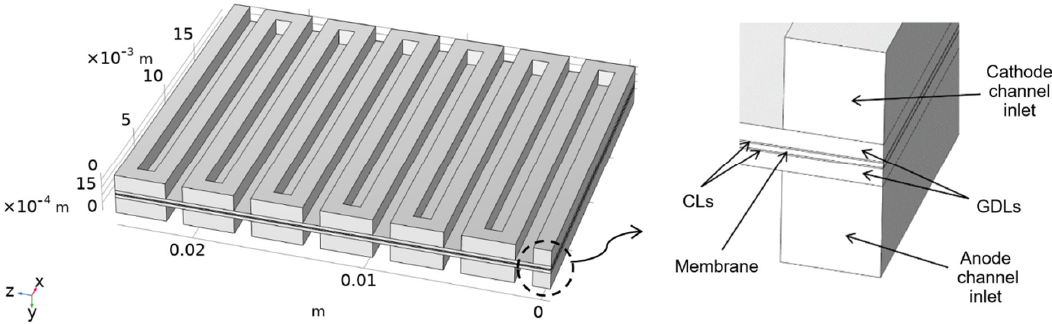
Figure 1. The computational domain with the 5-cm 2 active area, constructed based on the experimental study [22], consists of flow channels, GDLs, CLs, and the membrane.